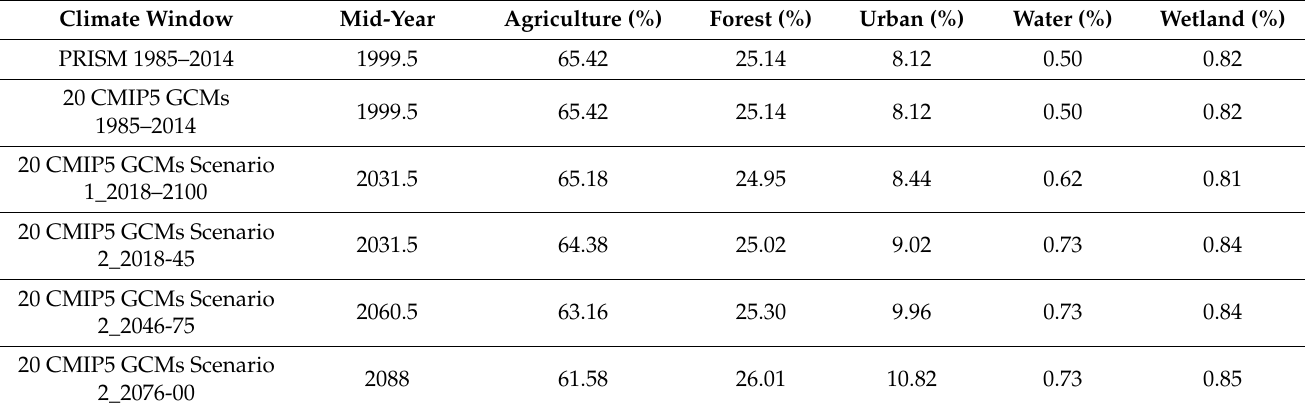
Table 2. Land use/land cover (LULC) forcing used in the simulation.